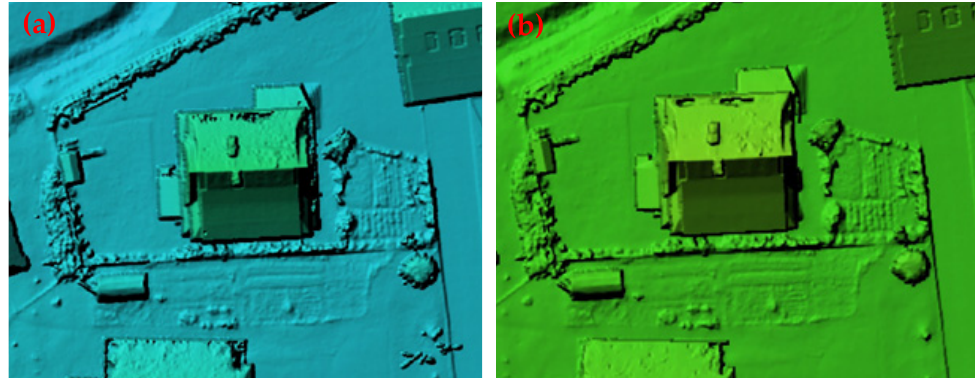
Figure 11. Comparison of DEMs with a resolution of 0.1 m/pix ( a ) DEM generated from point clouds ( b ) DEM generated from depth maps.